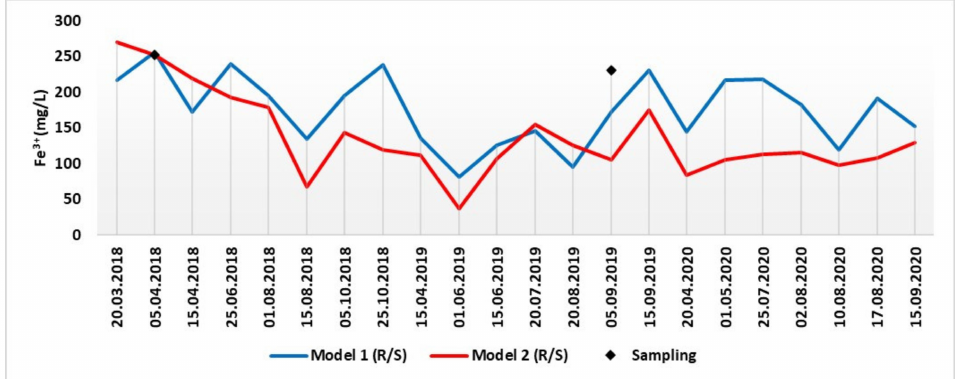
Figure 20. Development of Fe 3+ concentration over time in the Lugteich